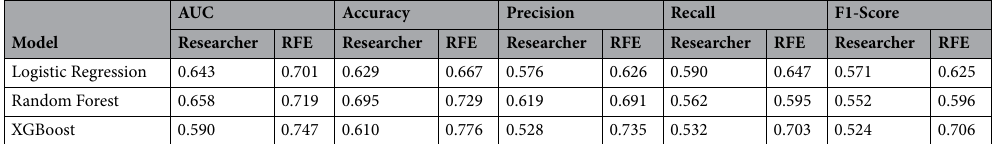
Table 3. Prediction results of relapse in RA patients using researcher/RFE-selected features calculated by each model. RA rheumatoid arthritis, RFE recursive feature elimination, AUC area under the